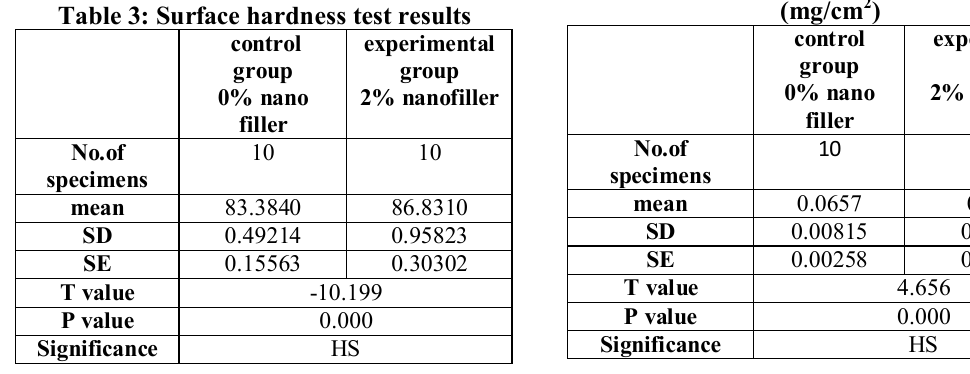
Table 6: water solubility test results